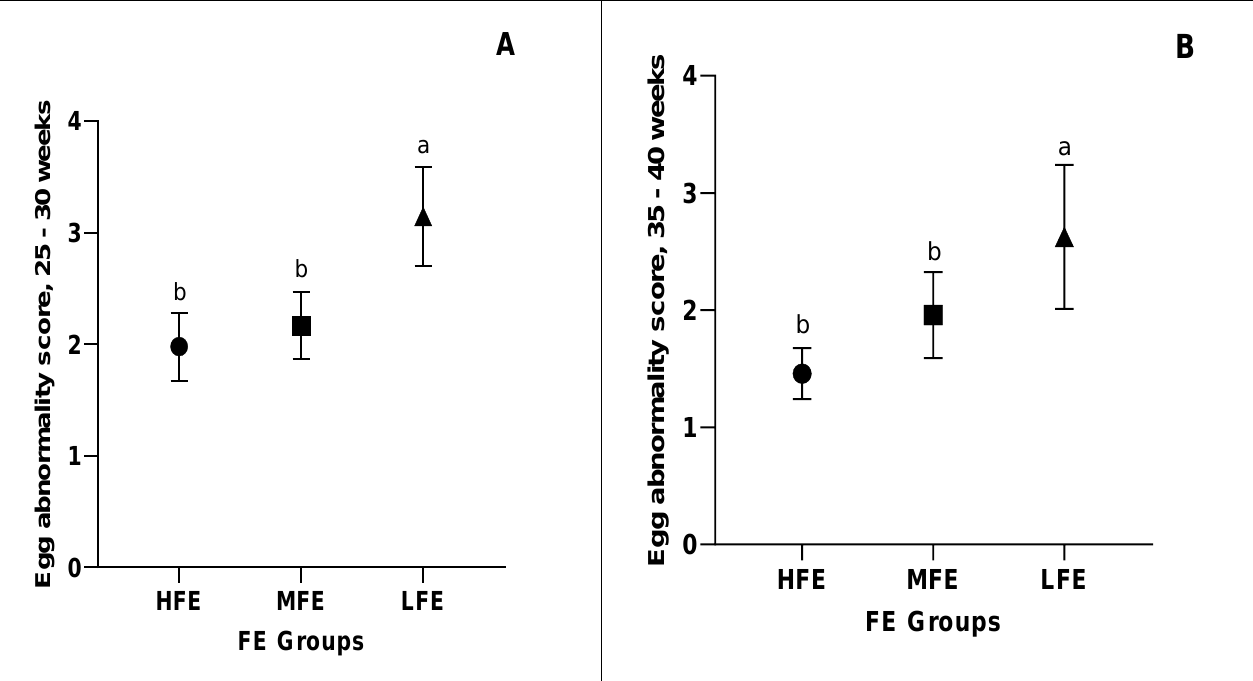
Figure 2. ( A ) Average egg abnormality score of individual ISA Brown hens aged 25–30 weeks based on differences in their feed efficiencies, n = 48 hens per FE group. ( B ) Average egg abnormality score of individually housed ISA Brown hens aged 35–40 weeks based on differences in their feed efficiencies, n = 48 hens per FE group. FE: Feed efficiency; HFE: High feed efficiency; MFE: Medium feed efficiency; LFE: Low feed efficiency. ab : Means not sharing a common superscript are significantly different at the 5% level of significance.